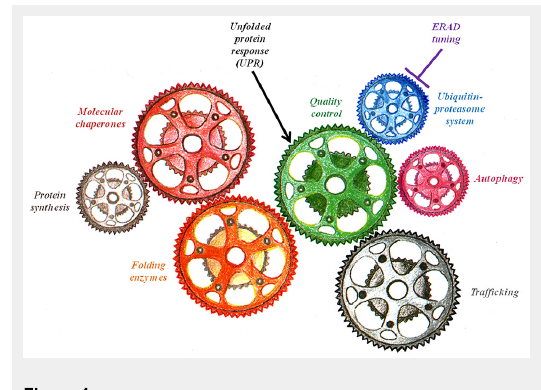
Schematic of the proteostasis network. The main components that regulate and maintain protein homeostasis (proteostasis) are illustrated as gears of a